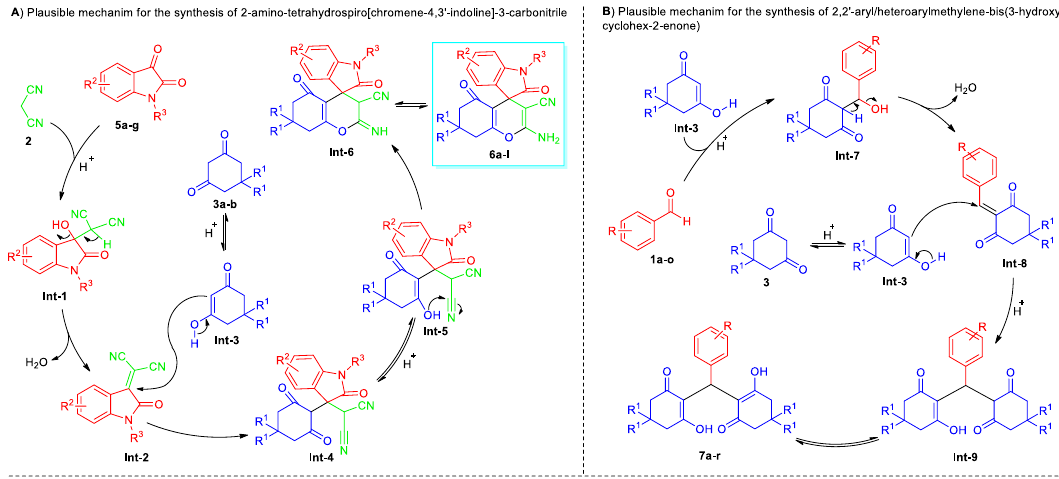
Figure 11. Plausible mechanism for the synthesis of 2-amino-tetrahydro-spiro[[chromene-4,3 ′ -indoline]-3- carbonitrile 6 and 2,2 ′ -aryl/heteroaryl-methylene-bis(3-hydroxy-cyclohex-2-enone) 7 .